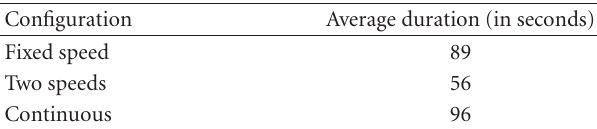
Figure 5: The appearances of white under di ff erent angles. Values are given in HSV.